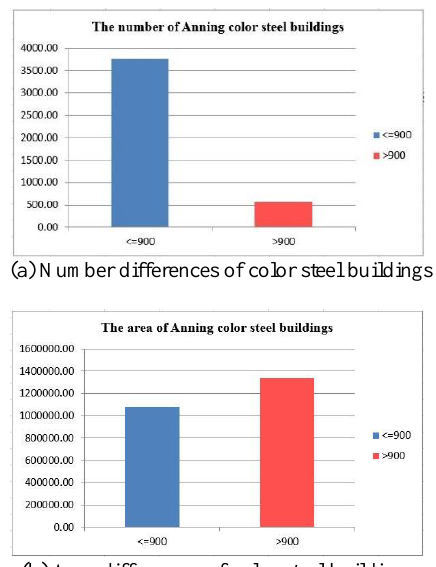
Figure 4 Statistical analysis of the color steel